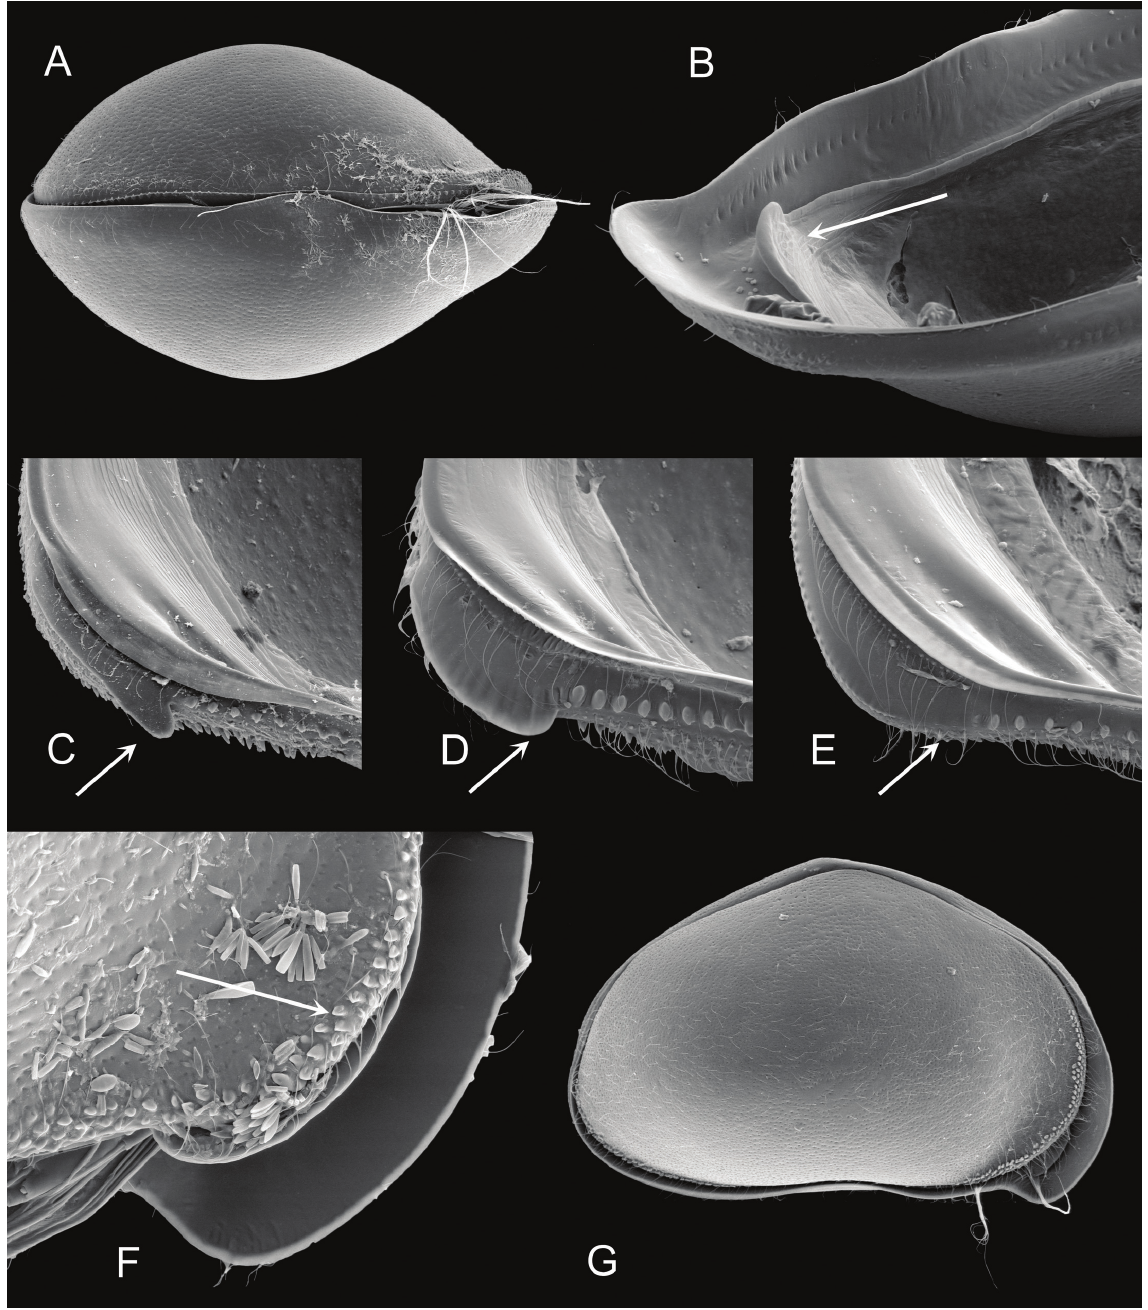
Fig. 4. General morphology of Bennelongia valves . A . B. cygnus sp. nov., ♀, CpV (WAM.C49378). B . B. cuensis sp. nov., ♀, LV dorso-anterior view, tilted, showing elevated inner list (WAM.C49408). C . B. cygnus sp. nov., ♀, RV, antero-ventral view, tilted, showing tear-like lapel and row of tubercles (OC.3311). D . B. lata sp. nov., ♀, RV, antero-ventral view, tilted, showing broad lapel and row of tubercles (specimen lost). E . B. kimberleyensis sp. nov., ♀, RV, antero-ventral view, tilted, showing absence of lapel and expansion of valve (WAM.C49433 allotype). F . B. frumenta sp. nov. ♀, CpRL view (WAM.C49383). G . B. gwelupensis sp. nov. ♀, CpRL view, detail of antero-ventral part (WAM. C49395A). Not to